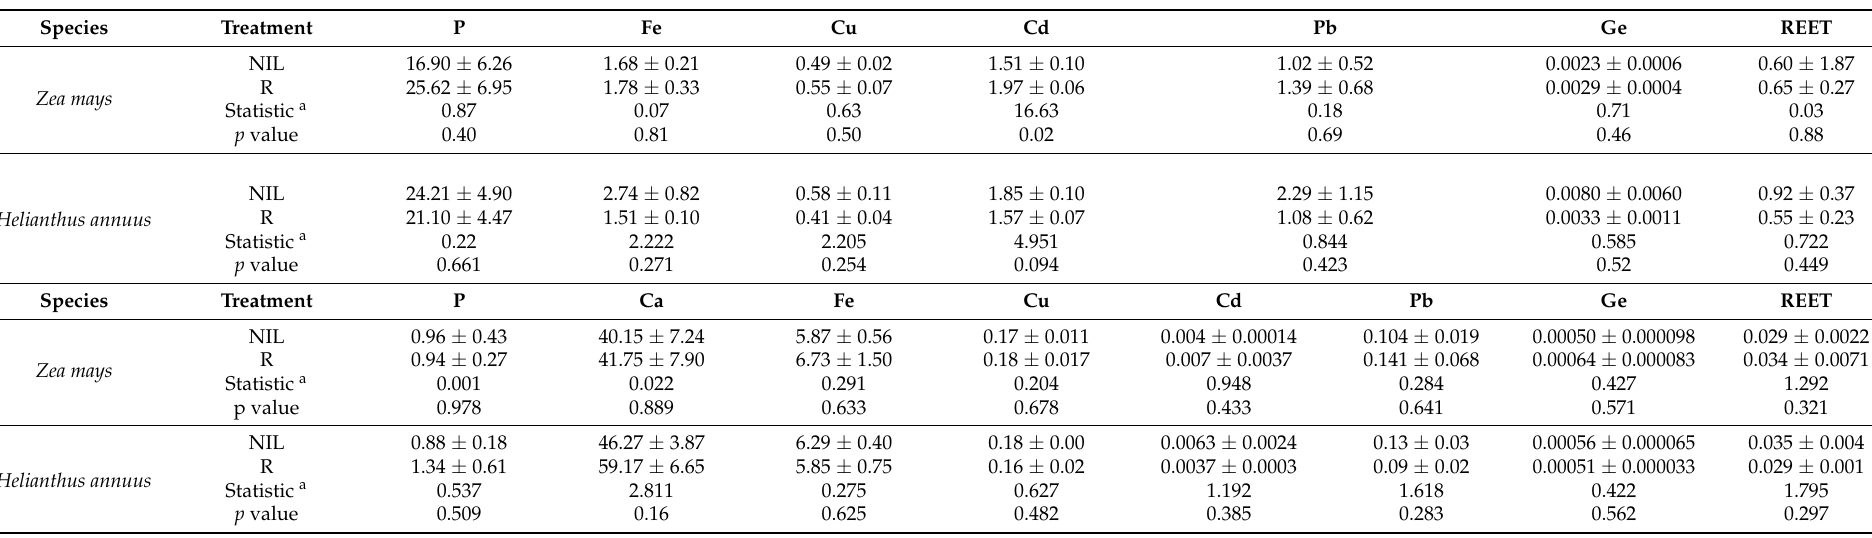
Table 2. Concentration ( µ g/g) of elements in root soils (upper section of the table =calcium chloride extraction; lower section of the table =water extraction). Mean ± SE, n = 3–4, NIL = reference, R = inoculated Soil. Statistics a means asymptotically distributed F statistic for Welch’s